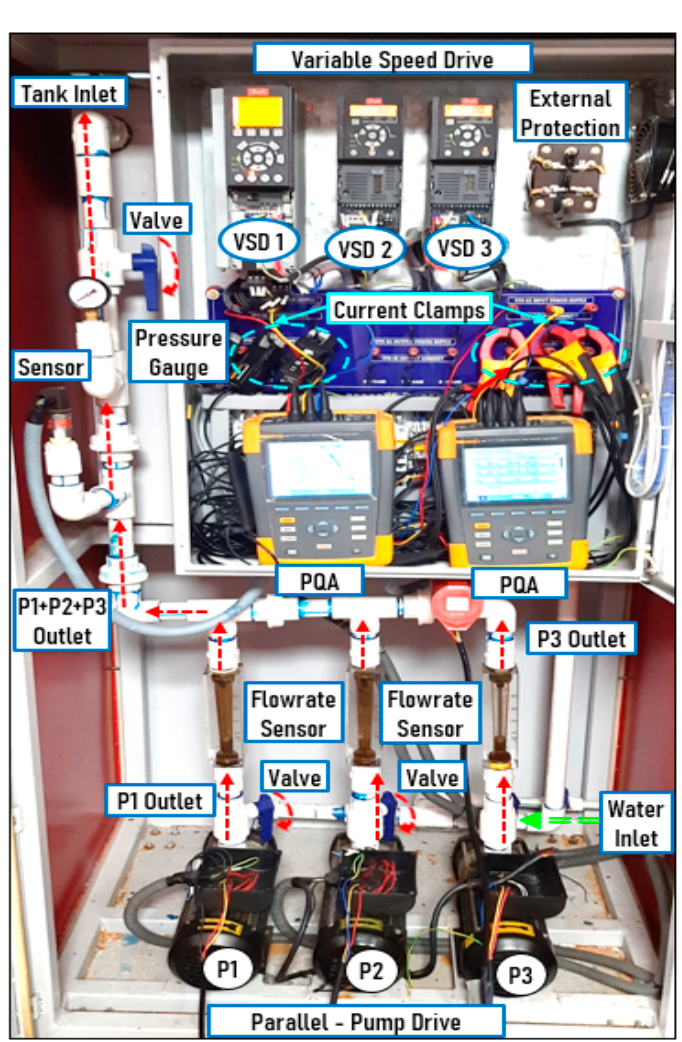
Figure 12. Single and multi ‐ parallel experimental setup.